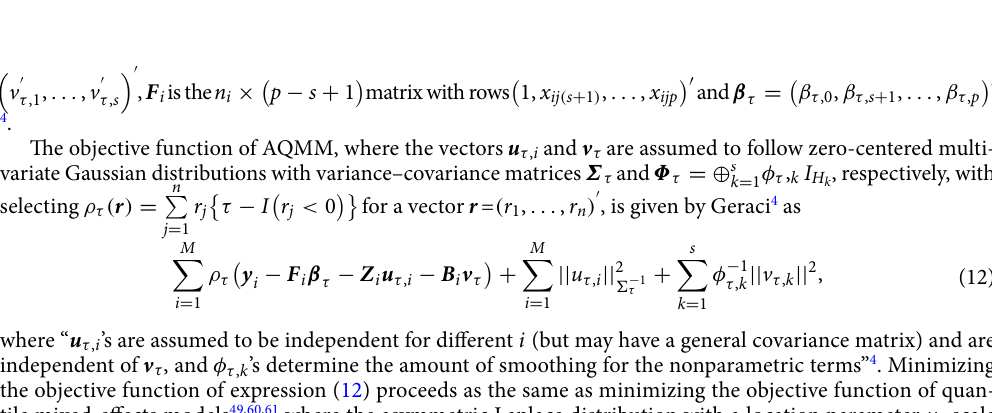
Table 2. Baseline descriptive statistics for categorical